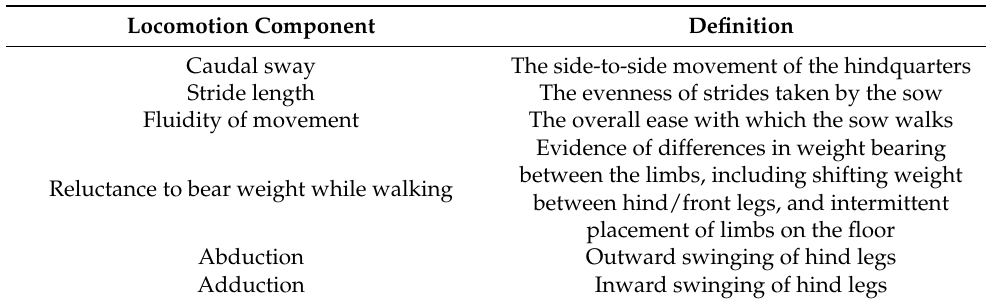
Table 2. Components of locomotion scored using a Visual Analogue Scale (VAS). The VAS ranged from 0 mm (perfect) to 150 mm (the most severe impairment possible).